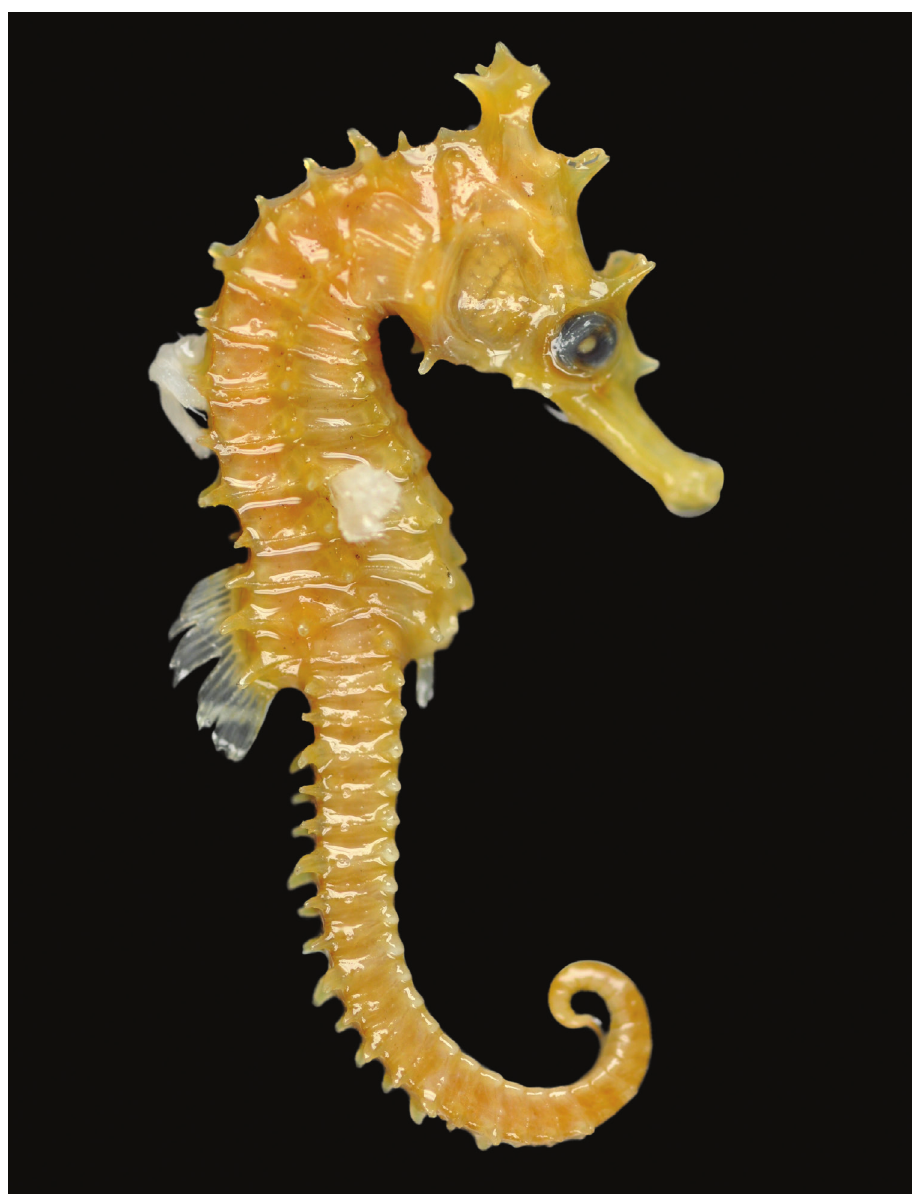
Figure 11. Hippocampus procerus , AMS I.A4205, juvenile female, non-type, Point Curtis, Queensland, Australia (photograph Jeff